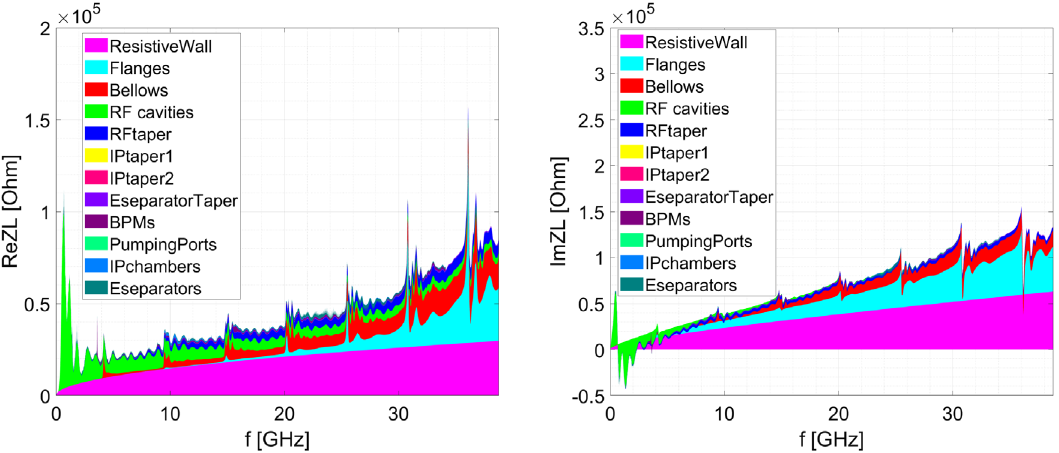
FIG. 2. The longitudinal impedance of